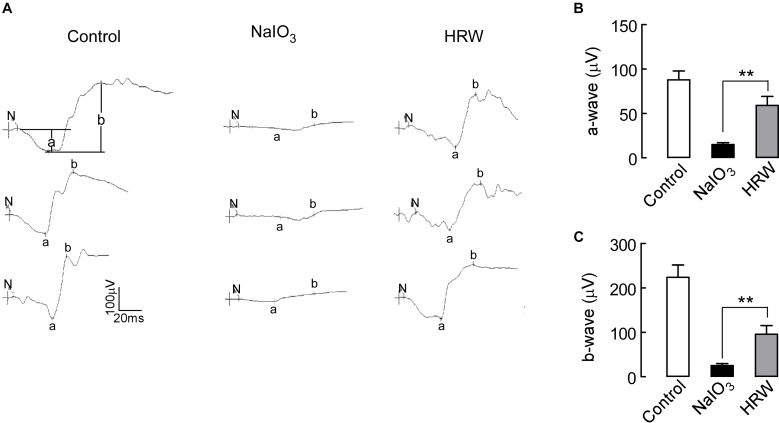
Effects of HRW on NaIO3-induced visual function impairment in mice. (A) ERG map of dark adaptation 3.0 in control, NaIO3, and HRW groups. N represents the start of stimulation, a represents the amplitude of the a-wave, and b represents the b-wave amplitude. (B,C) Quantification of the a-wave and b-wave amplitudes, respectively. Values are presented as the mean ± SEM, n = 10, ∗∗P < 0.01 vs. the NaIO3 group.